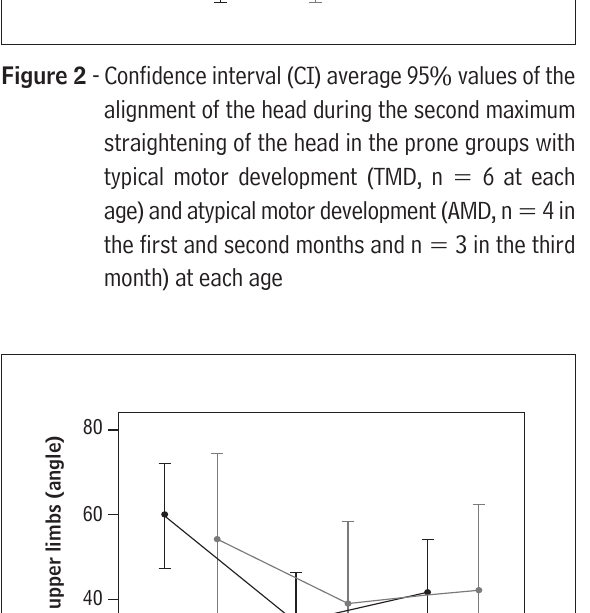
The analysis of variance, in a comparison between the groups and between the ages of the children, showed a statistically significant difference for head alignment between the TMD and the AMD group (F = 46.84, p = 0.00). A significant difference was also observed between the ages of children (F = 23.57, p = 0.00). The Tukey HSD test showed that the differences were between the first and the third month (p = 0.00) and between the second and the third month (0.00). However, no interaction between groups and ages (F = 1.94, p = 0.15) (Figure 2) was observed. Regarding the alignment of the upper limbs, the same analysis showed no difference between the TMD and the AMD group (F = 0.00, p = 0.97). The alignment of the up- per limbs differed between the ages of the children (F = 4.41, p = 0.01). The Tukey HSD test showed that the difference was between the first and the second month (p = 0.01) (Figure 3); no interaction between the factors and the age groups (F = 0.76, p = 0.27) was observed.